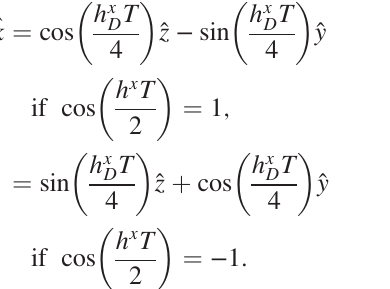
40 and (b) h x D ¼ D ¼